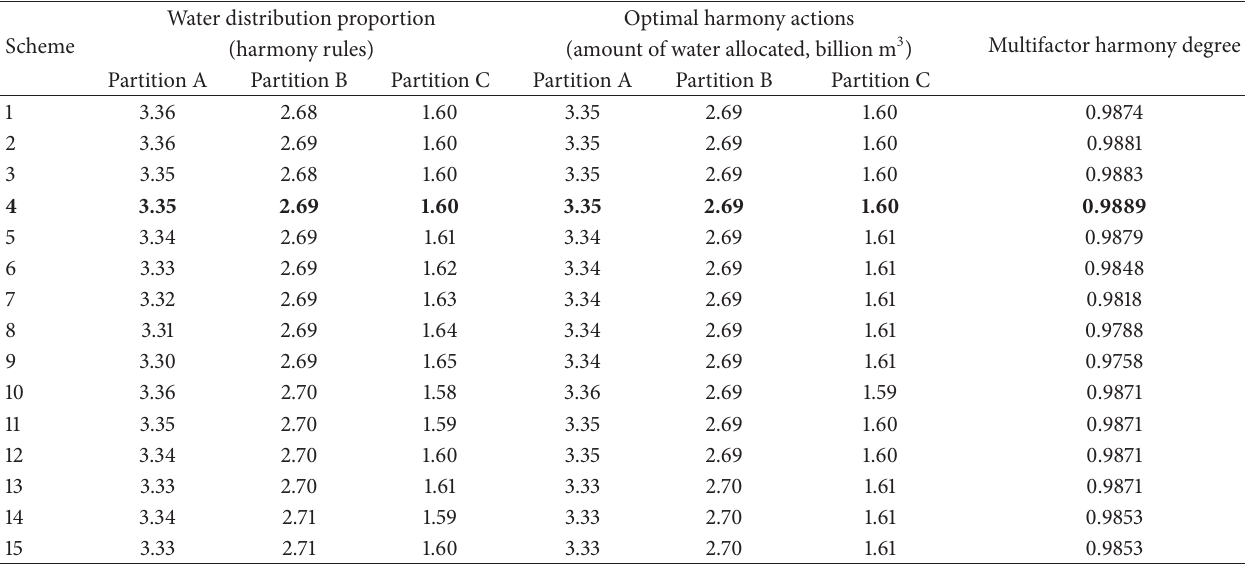
Table 3: Optimal harmony action and harmony degree for different schemes of water allocation with varied harmony rules (proportion of water